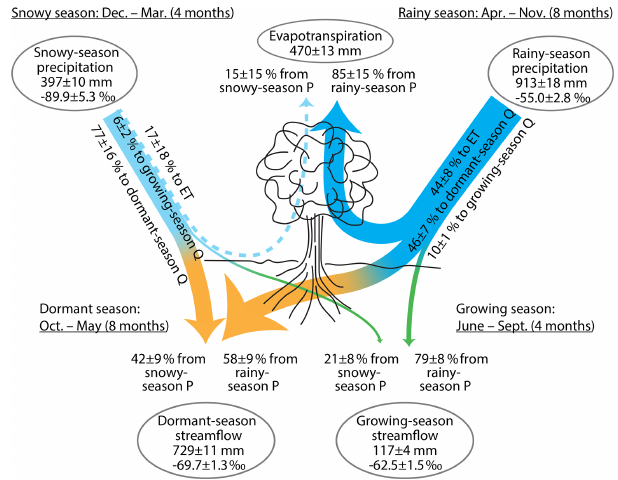
Figure 8. Partitioning of snowy-season (December–March) and rainy-season (April–October) precipitation (P) into evapotranspira- tion (ET) and streamflow (Q) during the dormant season (October– May) and the growing season (June–September), inferred from an- nual water fluxes and volume-weighted δ 2 H at Hubbard Brook Watershed 3. About half of rainy-season precipitation eventually evapotranspires, and this accounts for almost all the annual evap- otranspiration flux; the contribution from snowy-season precipita- tion is zero within error. About 10% of rainy-season precipitation accounts for four-fifths of growing-season streamflow, and the re- maining (46%) rainy-season precipitation accounts for about half of dormant-season streamflow. About three-fourths of snowy-season precipitation become dormant season streamflow, and perhaps one- sixth eventually evapotranspires (but this is zero within error). A small but well-defined proportion is also carried over to the grow- ing season, accounting for one-fifth of growing-season streamflow. All quantities are shown ± standard errors. Widths of lines are ap- proximately proportional to water fluxes. Fluxes within 1 standard error of zero are shown by dashed